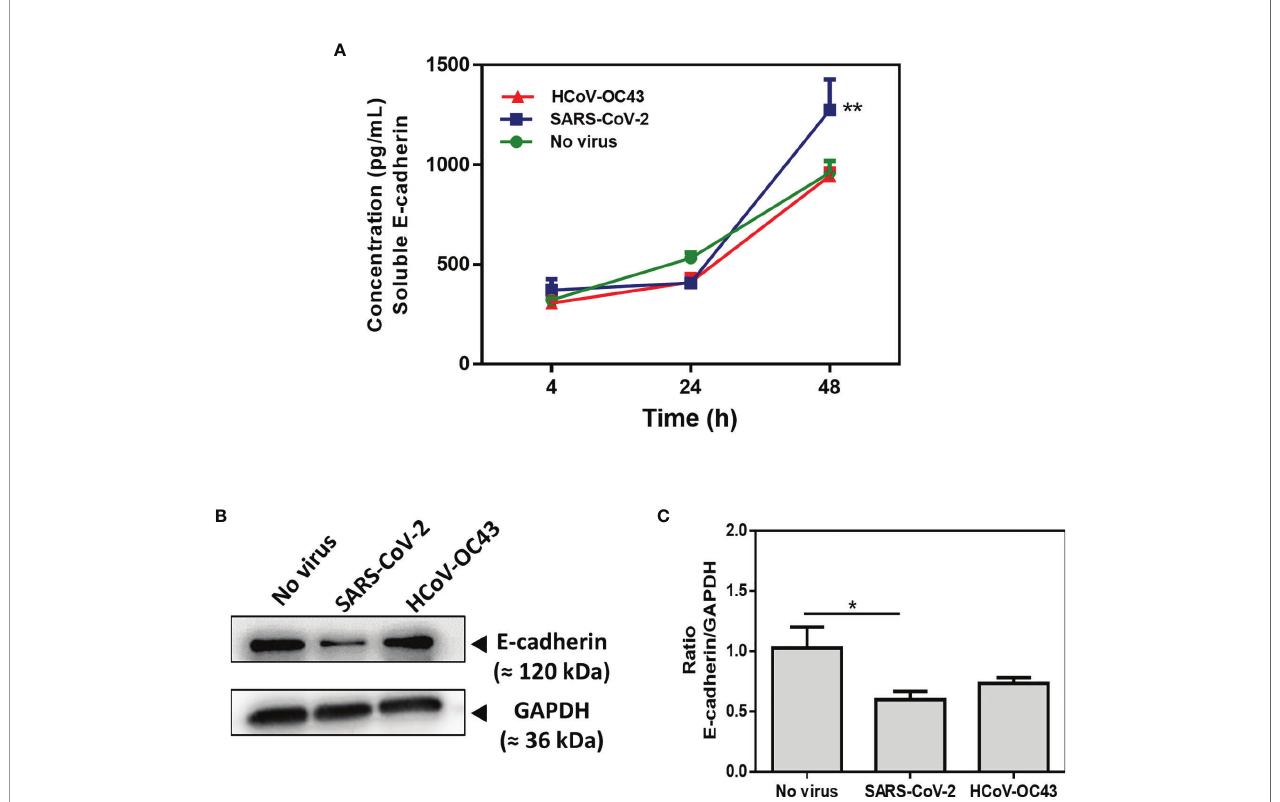
FIGURE 6 | Expression of E-cad and sE-cad. in Caco-2 cells. (A) Quanti fi cation of sE-cad (n=4) in the cell-culture supernatant of virus-free Caco-2 cells and cells exposed to coronaviruses SARS-CoV-2 or HCoV-OC43 at an MOI of 0.5 for 4 hours, 24 hours and 48 hours respectively, using antigen-speci fi c ELISA. The results are the average of quadruplicates. (B) Western blot analysis of E-cad expression in virus-free Caco-2 cells and cells exposed for 48h to SARS-CoV-2 or HCoV- OC43 coronaviruses. GAPDH was used as loading control. (C) Quantitative representation of E-cad protein expression by Caco-2 cells infected or not with SARS- CoV-2 or HCoV-OC43 normalized with respect to GAPDH. The Image J program was used to quantify the Western blot bands intensity. The symbol ** means a p-value < 0.01. The symbol * means a p-value <